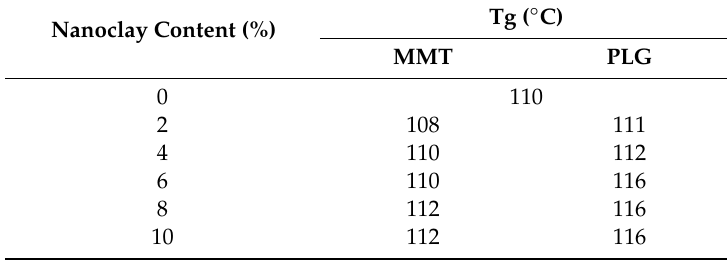
Table 2. Glass transition temperatures (Tg) of dental